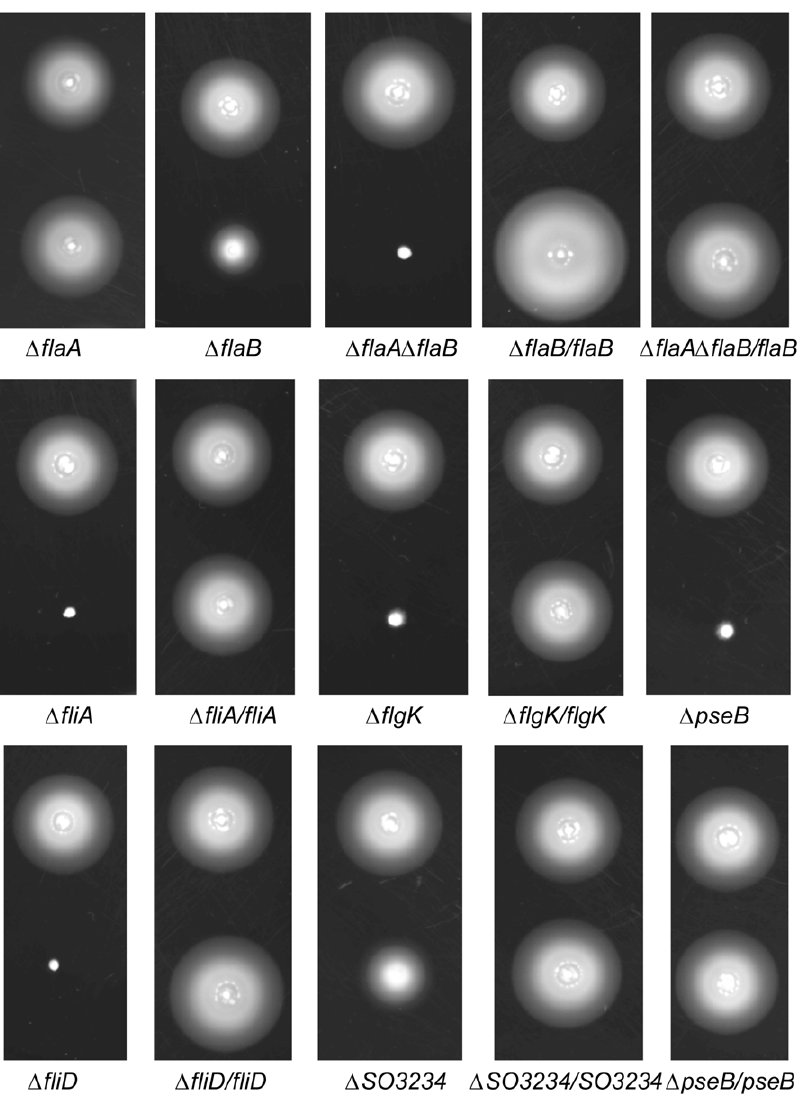
Figure 2. Motility of S.oneidensis wild type and isogenic mutation strains. In all panels, the mutant strain (lower) was compared to its parentalwild type (upper) in the swimming assay. Each mutant containing its complementation vector is presented as the mutant/the gene. For example, the D flaB / flaB strain refers to the D flaB mutant containing complementation vector pBBR-FLAB.